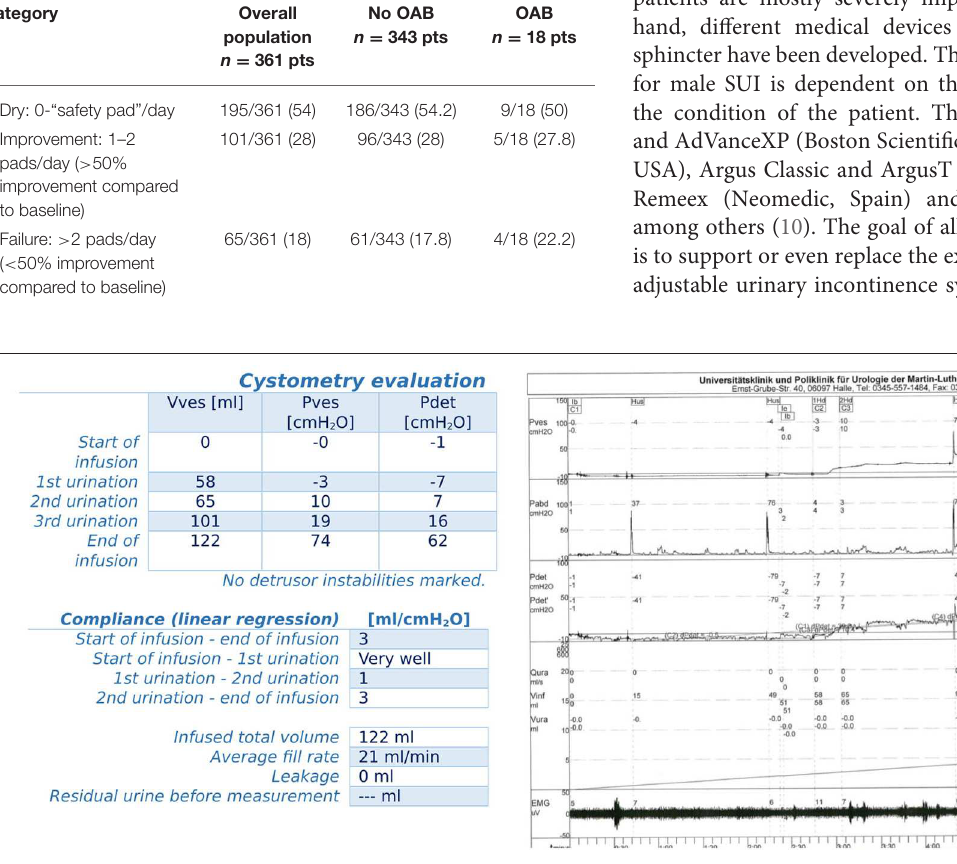
FIGURE 1 | Urodynamic evaluation of a patient with a newly diagnosed, derailed and primarily insulin-dependent type II diabetes mellitus and OAB voiding dysfunction; urodynamic evaluation showed a low-compliance urinary bladder.